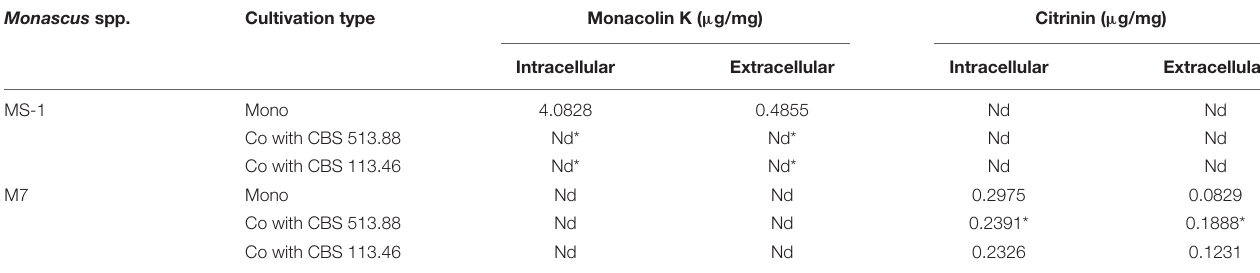
TABLE 1 | Monacolin K and citrinin variation when Monascus spp. were co-cultured with Aspergillus niger on PDA media. Monascus spp.